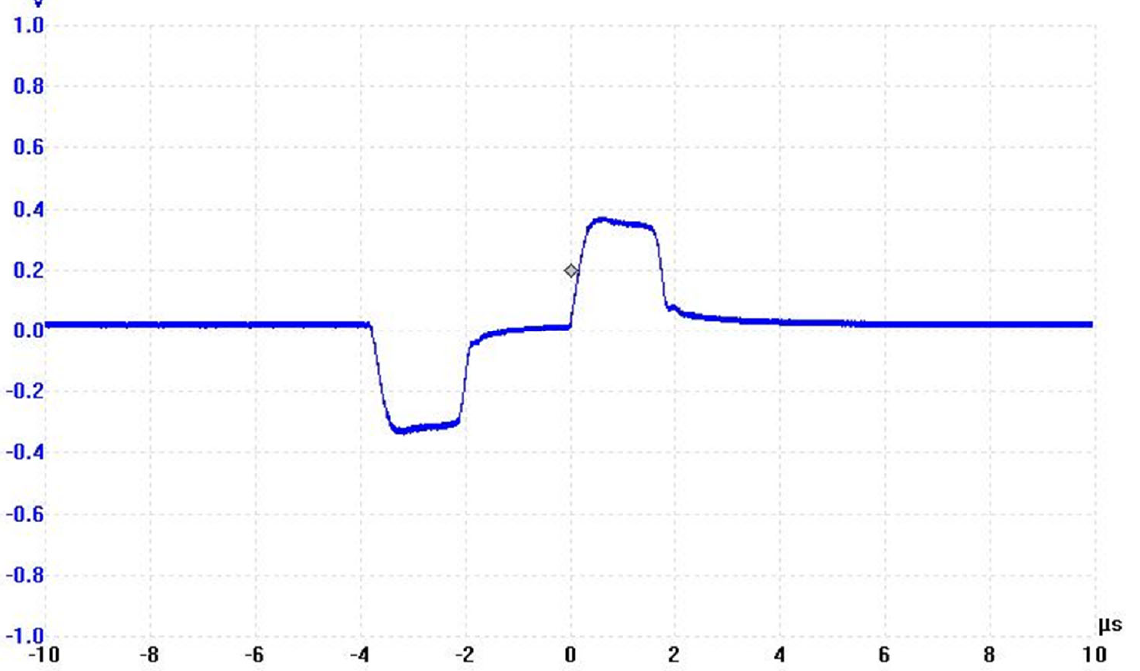
Figure 2. A square bipolar pulse generated at the University of Auckland [24].